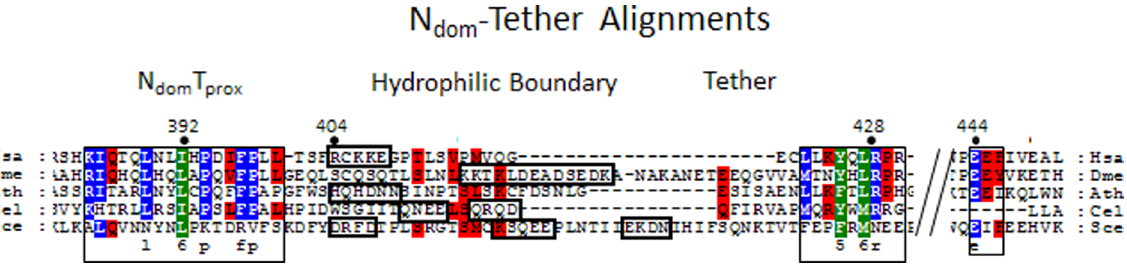
Figure 10. Tether alignments. The long form of tRNase Z from H. sapiens (Hsa; Accession # NP_060597), D. melanogaster (Dme; Q8MKW7), A. thaliana (Ath; AAM51378), C. elegans (Cel; O4476) and S. cereviseae (Sce; NP013005.1) were aligned using Clustalw. The full length alignments are presented in Supplemental Figure SF2 in File S1. Numbers at top are for H. sapiens tRNase ZL. Regions presented begin with the last identified homology block (N dom -T prox ) in the amino domain [41] proximal to tether and include two smaller homology blocks in tether (rectangular enclosures).//indicates omitted sequence. Small bold rectangles enclose hydrophilic patches that mark the N dom -tether boundary.